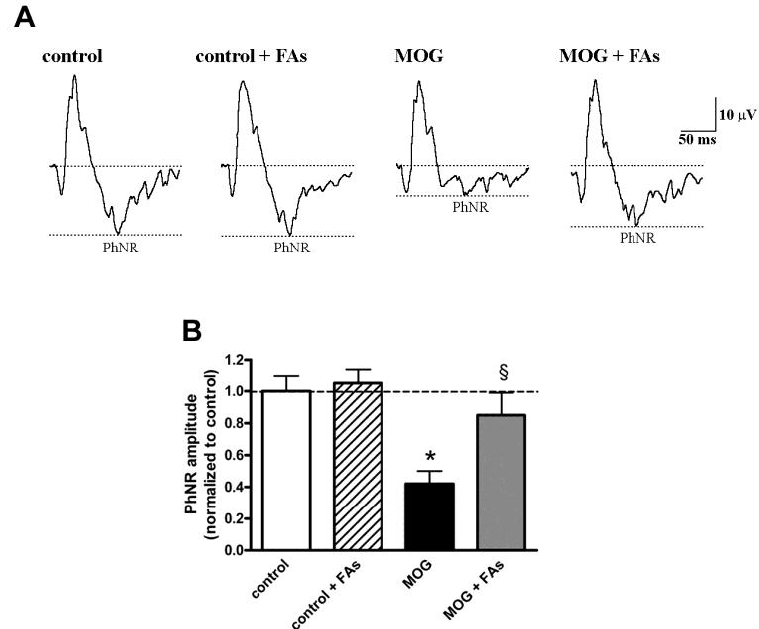
Figure 5. Dietary supplementation with FAs almost prevents MOG-induced reduction of photopic negative response (PhNR) amplitude. ( A ) Representative recordings in control and MOG-treated mice with or without FAs supplementation. ( B ) PhNR amplitudes were normalized to the amplitude of the control group. Data are shown as the mean ± S.E.M. ( n = 6 for each experimental group). * p < 0.001 versus control. § p < 0.001 versus MOG (One way ANOVA followed by the Newman–Keuls multiple comparison post-hoc test). White bars, control mice; dashed bars, control mice with FAs supplementation; black bars, MOG-treated mice; grey bars, MOG-treated mice with FAs supplementation.